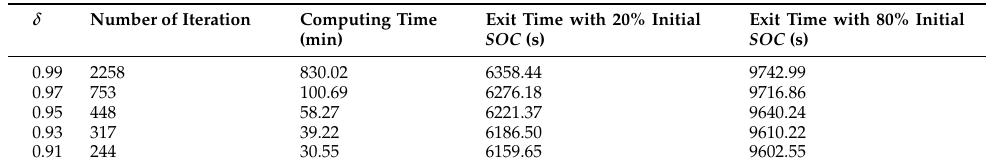
Table 2. Average exit time for different discount factor.